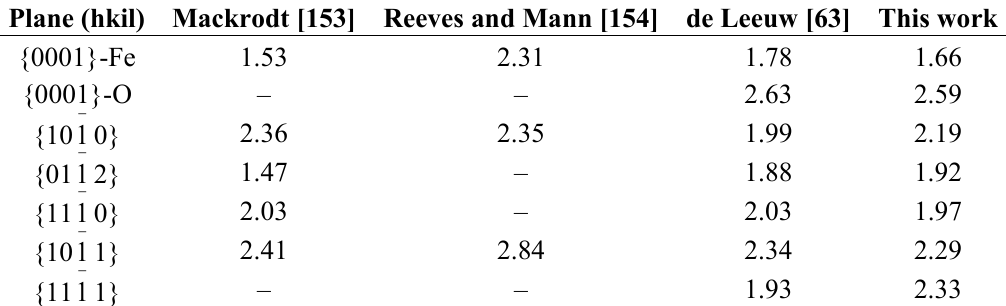
Table 2. Calculated relaxed surface energies for selected surfaces of hematite (J m −2 ). Plane (hkil) Mackrodt [153] Reeves and Mann [154] de Leeuw